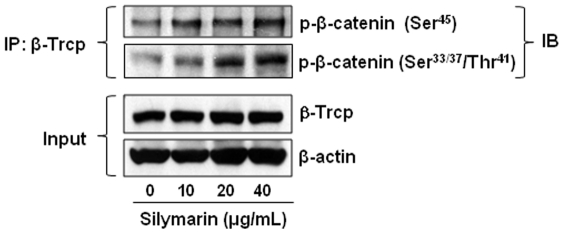
Treatment of melanoma cells with silymarin enhances binding of β-TrCP with phospho forms of β-catenin.Cells were treated with and without silymarin for 24 h and cell lysates were prepared. In binding assay, β-TrCP was immunoprecipitated using specific antibody from total protein lysates followed by western blot analysis for phospho forms of β-catenin, as detailed in Materials and Methods. IP, immunoprecipitation; IB, immunoblotting.